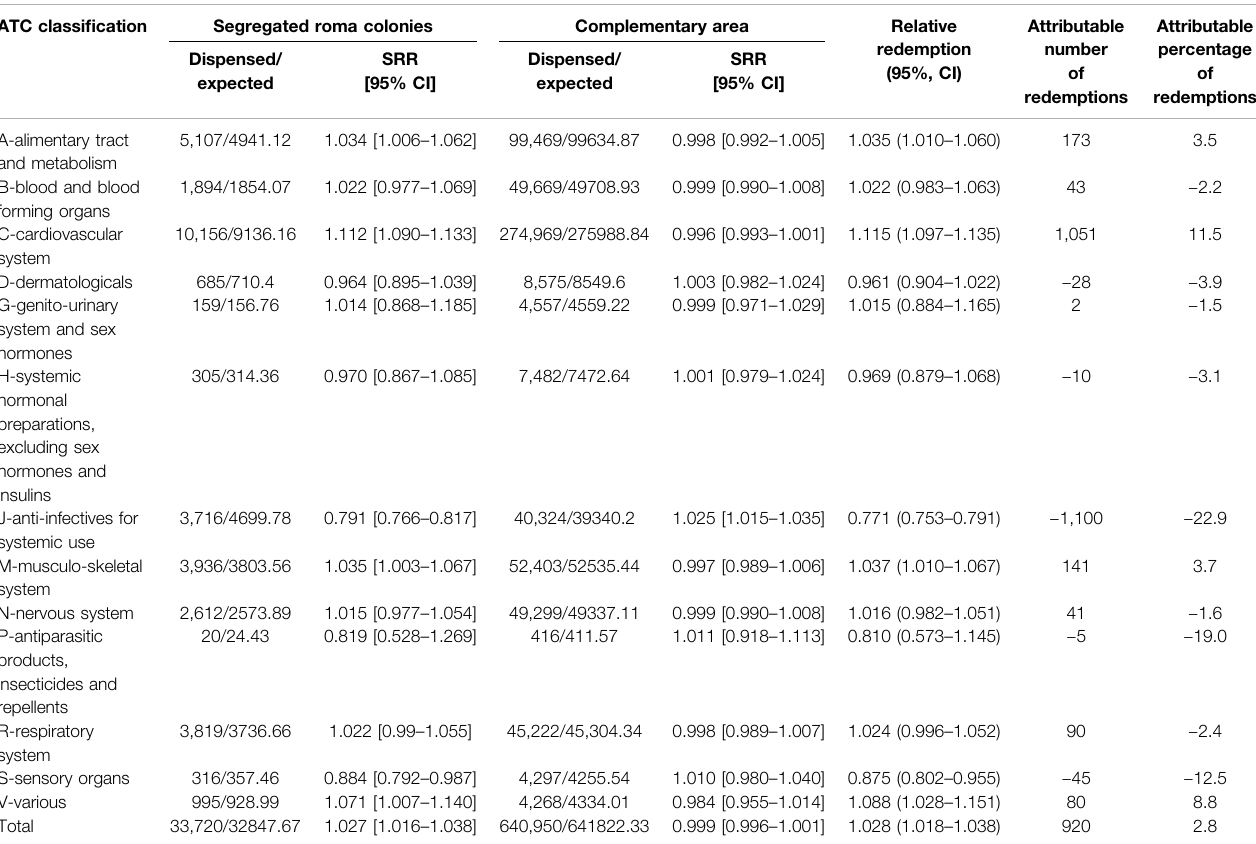
TABLE 2 | Standardized redemption ratios by ATC class among segregated Roma colonies and complementary